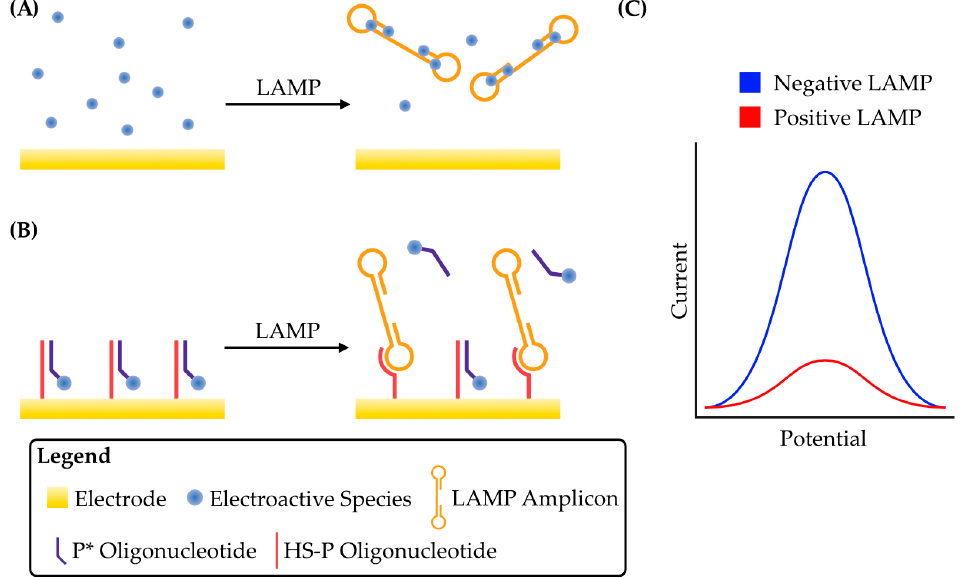
Figure 2. Schematic strategies for the detection of LAMP amplicons by sequestration of an electroactive species from the electrode surface. ( A ) Before LAMP, an electroactive species such as methylene blue or Hoechst 33258 is free to diffuse to the electrode surface, producing a relatively large faradaic current. As LAMP proceeds and amplicons are produced, the electroactive species binds to DNA, reducing its effective concentration and leading to a reduction in peak current. ( B ) An electrode functionalized with an oligonucleotide probe, HS-P. Before LAMP, a complementary oligonucleotide, P*, conjugated to an electroactive species is free to bind HS-P. This concentrates the electroactive species at the electrode surface and gives a large peak faradaic current. As LAMP amplicons are produced, they compete with P* for binding to HS-P and displace them from the surface, reducing the peak current. Adapted from [40]. ( C ) Schematic of a typical voltammogram for both detection strategies. In both cases illustrated in A and B, the net effect is sequestration of the elec- troactive species from the electrode, and therefore the peak current generated during voltammetry is reduced.